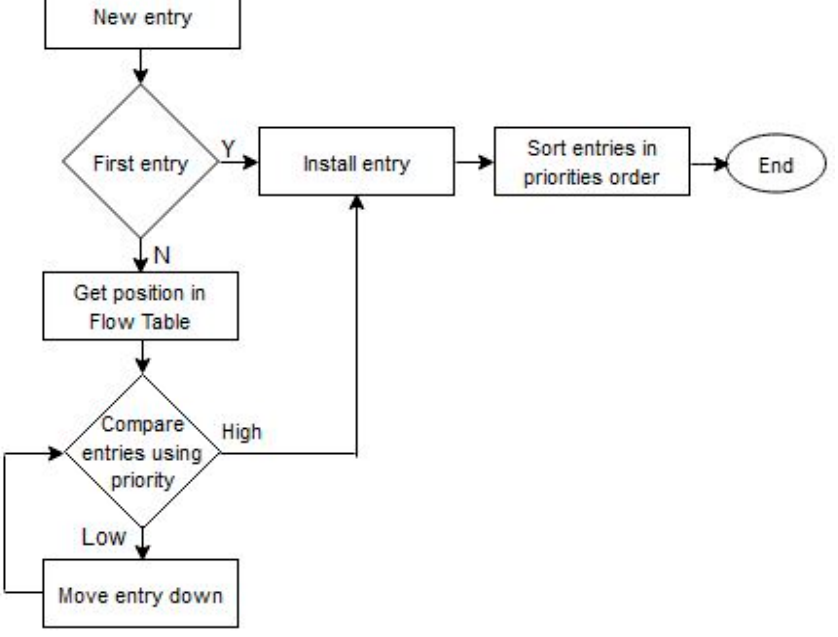
Figure 6. Example of TCAM Rule Update Operation.